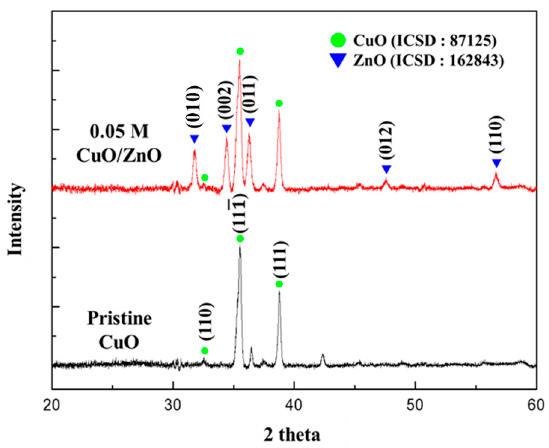
Figure 4. XRD analysis of the pristine CuO and the 0.05 M CuO/ZnO gas